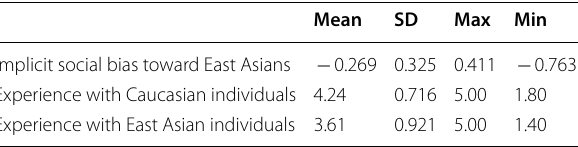
Table 1 Descriptive statistics on implicit social bias